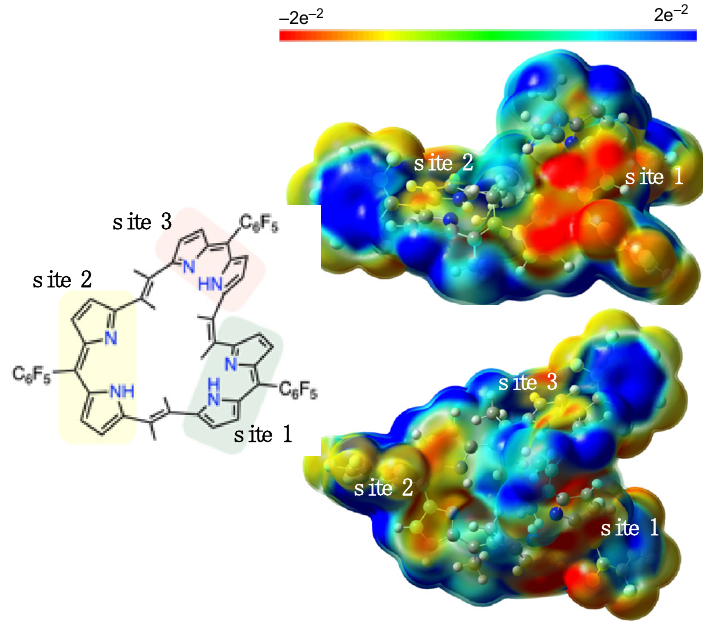
Figure 6. Electrostatic potential surface of Me-Hex. On top of the electrostatic potential surface, site 3 is located behind site 1.